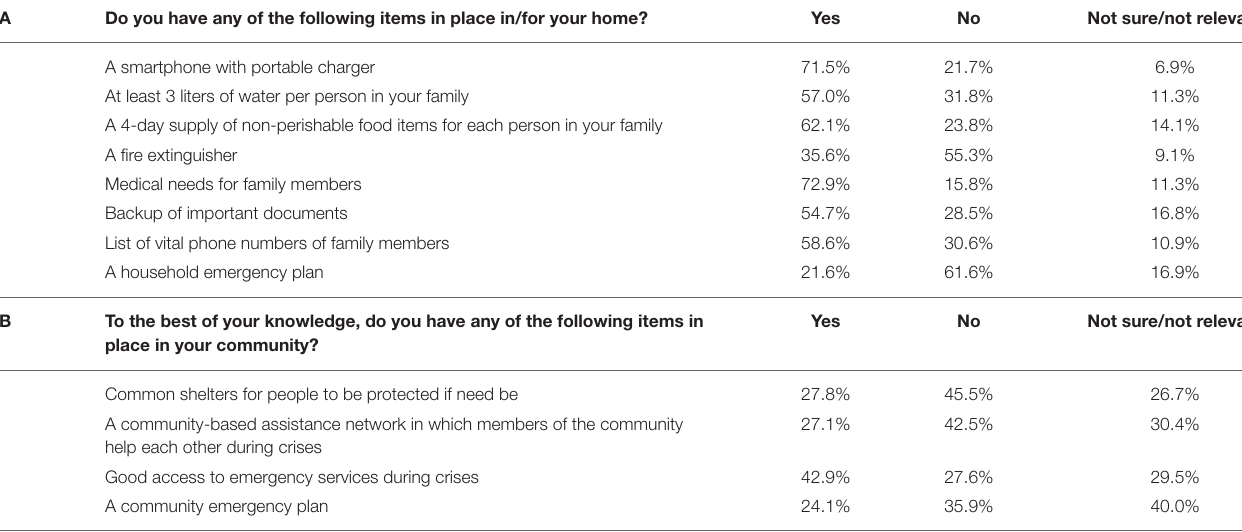
TABLE 3 | Distribution of compliance with (A) household adjustments and (B) communal capacities to prepare for emergencies ( N = 4,013).